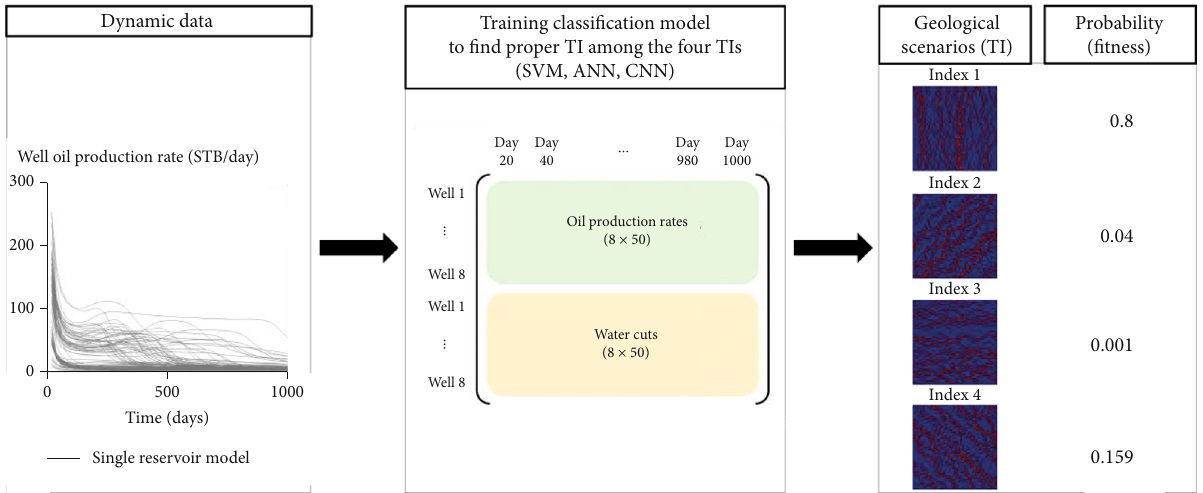
Figure 1: The concept of a machine learning-based TI classi fi cation model.